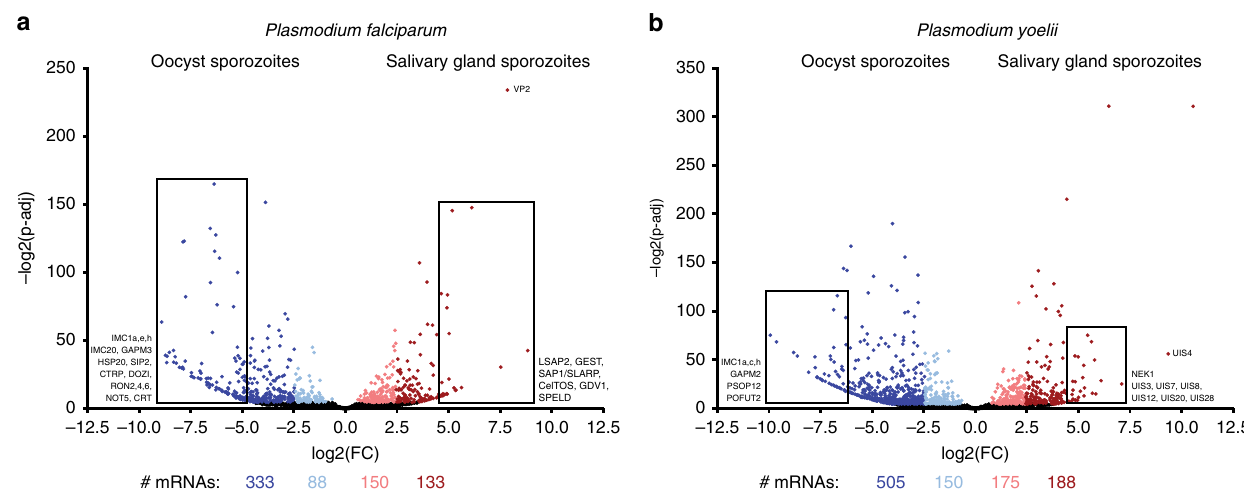
Fig. 1 Comparative transcriptomics of oocyst and salivary gland sporozoites. RNA from puri fi ed a P. falciparum or b P. yoelii sporozoites isolated from oocysts or the salivary glands was assessed by RNA-seq, and transcript abundances compared by DEseq2. Transcripts are plotted based upon fold change (between oocyst sporozoites and salivary gland sporozoites) and adjusted p value (signi fi cance of differential expression), with mRNAs shaded in lighter (±1 to 2.5 log 2 fold change) or darker shades (>2.5 log 2 fold change). Notable, differentially expressed transcripts are